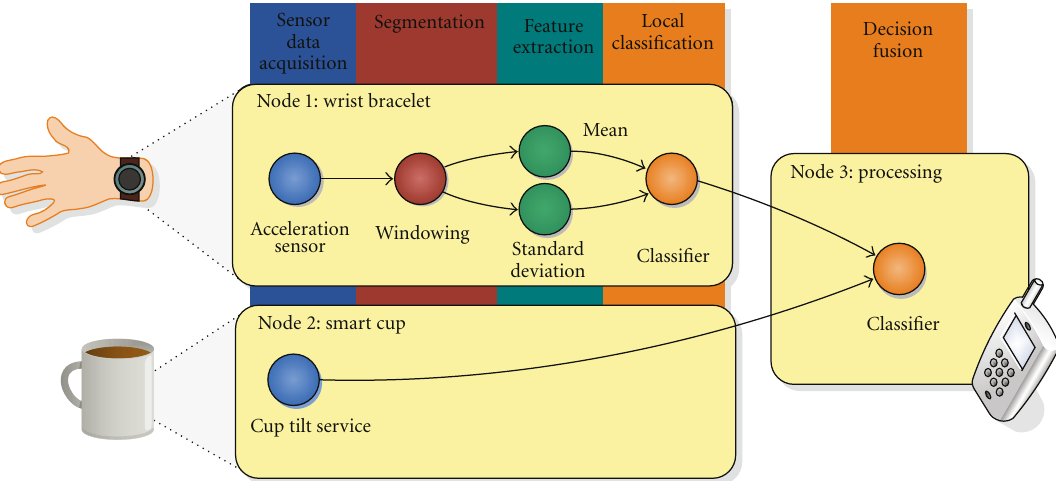
Figure 2: Illustration of a service graph doing “drink detection” from a Titan node placed on a cup and one placed on the wrist. The service graph is illustrated, together with one particular runtime instantiation of the graph on the sensor